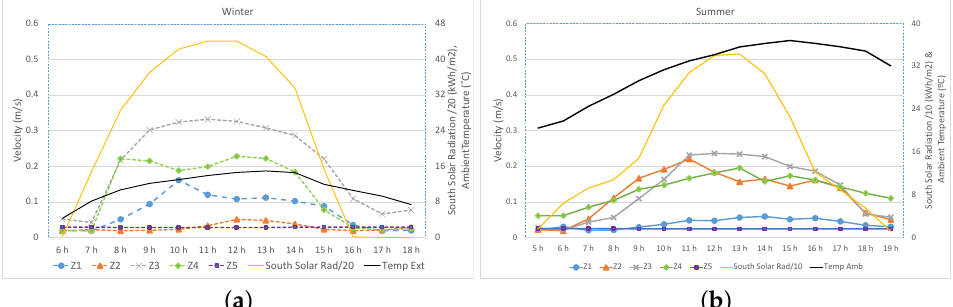
Figure 14. Closed ventilation grills. Trend of the measured air cavity velocity: ( a ) for a winter day (2 January 2021); ( a ) for a summer day (24 June 2021). South solar radiation and ambient temperatures are reported.